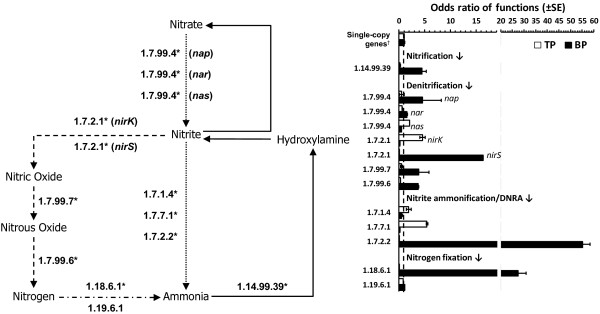
Enrichment of enzymes in the nitrogen metabolic pathway. Diagram with the enzyme classification (identified by their Enzyme Commission number; EC number) for each step in the nitrogen pathway. Asterik (*) indicate components that are significantly different between the two samples (q < 0.05) based on the Fisher’s exact test using corrected q-values (Storey’s FDR multiple test correction approach) (Table 2). Bar chart shows the odds ratio values for each function. An odds ratio of 1 indicates that the community DNA has the same proportion of hits to a given category as the comparison data set [24]. Housekeeping genes: gyrAgyrBrecArpoA and rpoB. Error bars represent the standard error of the mean.